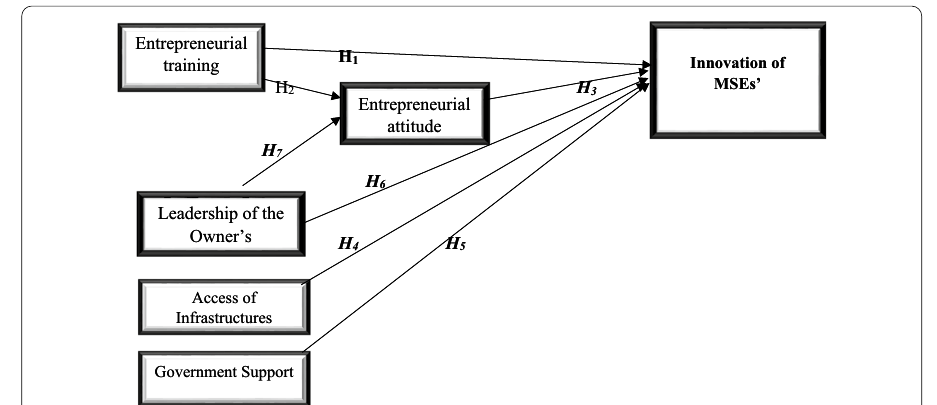
Fig. 1 Conceptual framework of the study. Source: Proposed by researchers